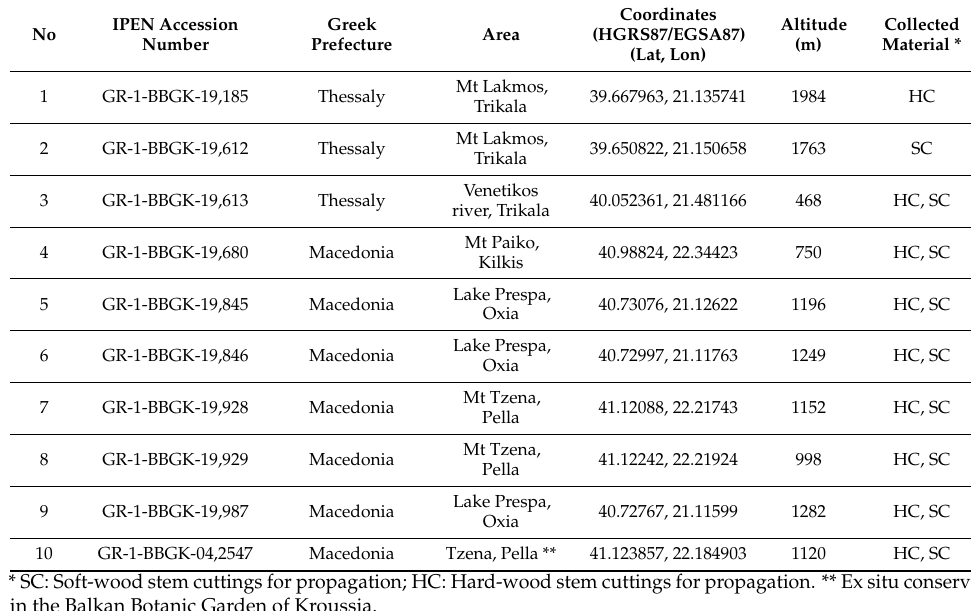
Table 3. IPEN (International Plant Exchange Network) accession numbers assigned to the collected samples of Greek native Amelanchier ovalis wild-growing populations, with collection details and the types of material collected.